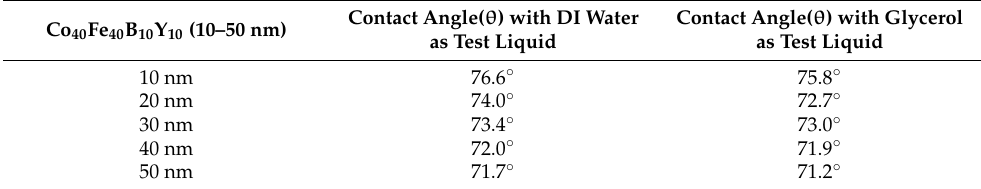
Table 6. Average contact angles of CoFeBY thin films after annealing at 300 ◦ C with DI water and